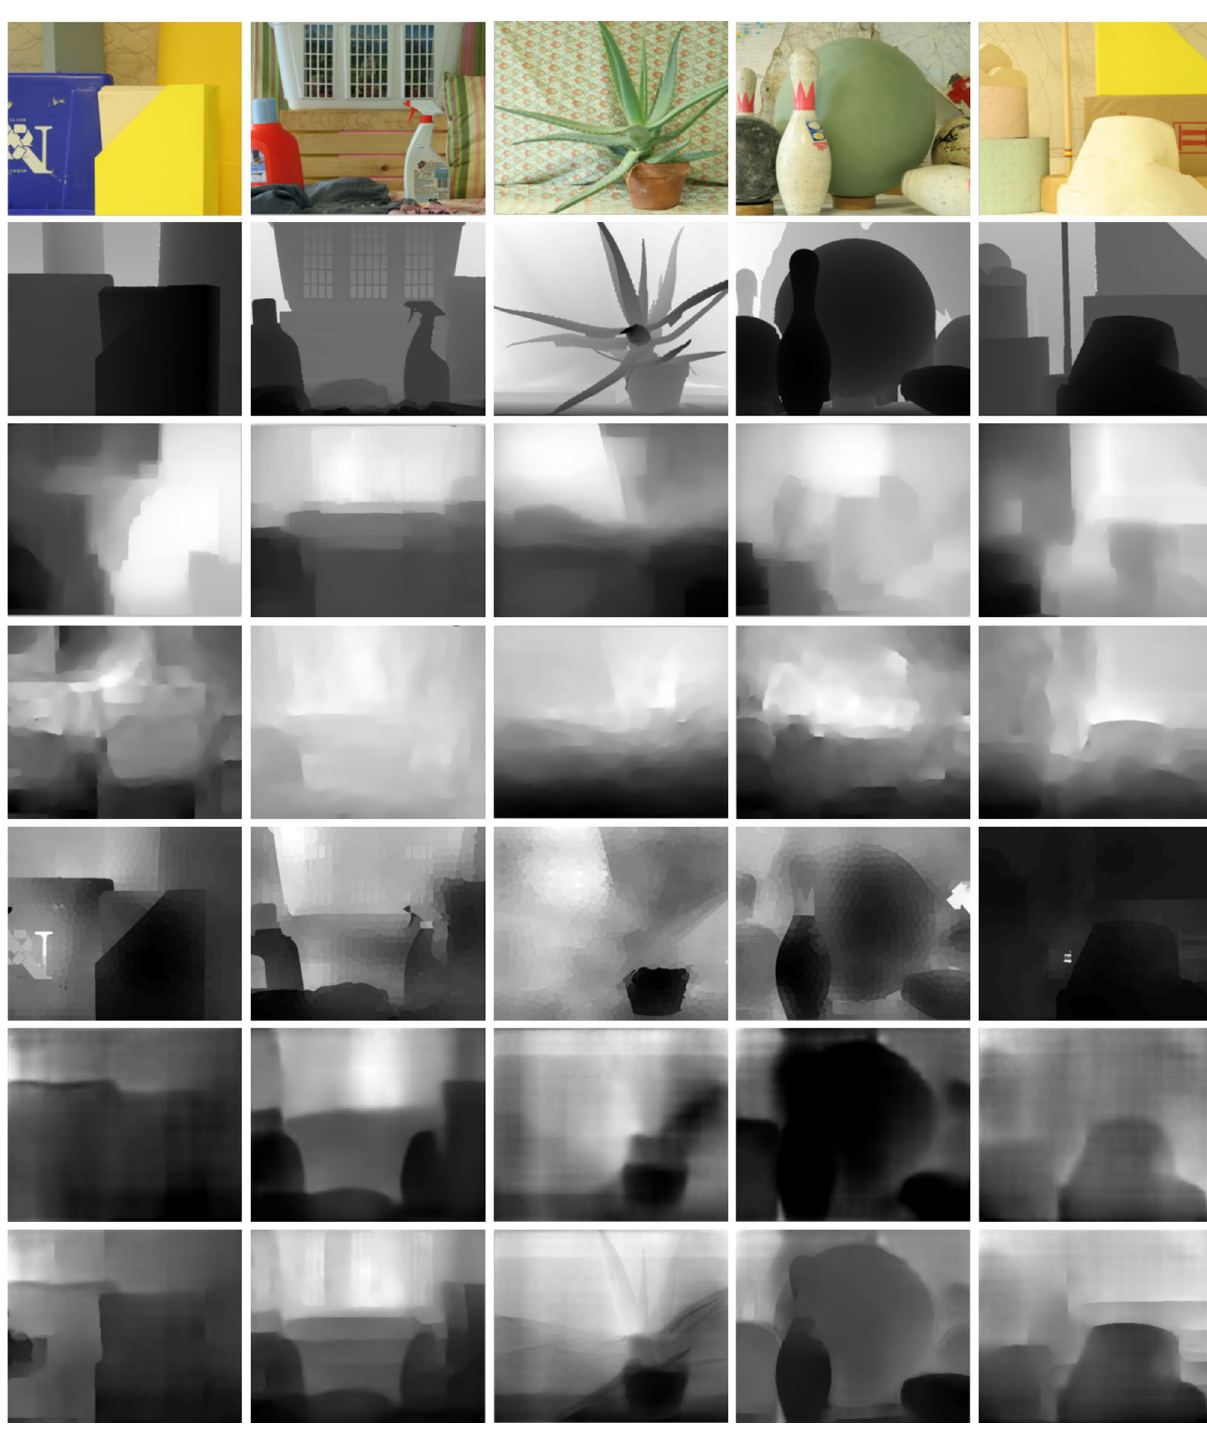
Fig. 5 Experimental results on MID dataset: First row: the input image, second row: the ground truth, third row: DT [11], fourth row: DA [12], fifth row: DCNF [22], sixth row: FCRN [23] and last row: the proposed